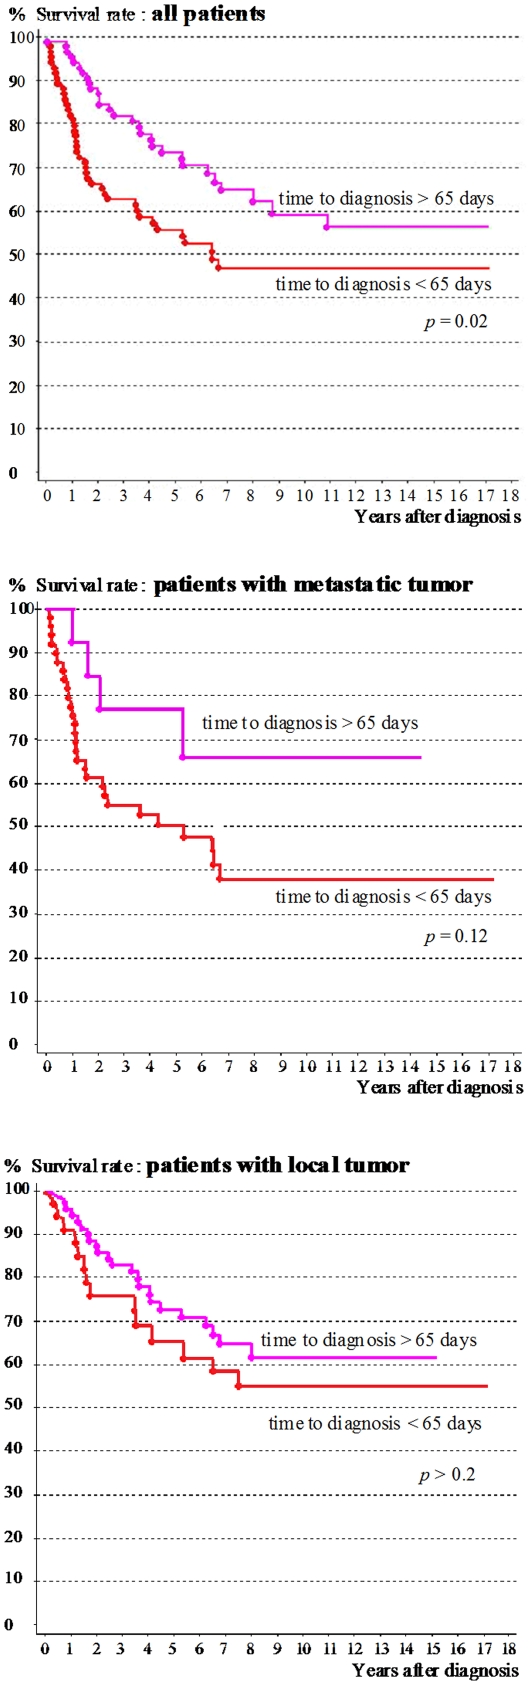
Survival according to time to diagnosis (more or less than the median of 65 days).